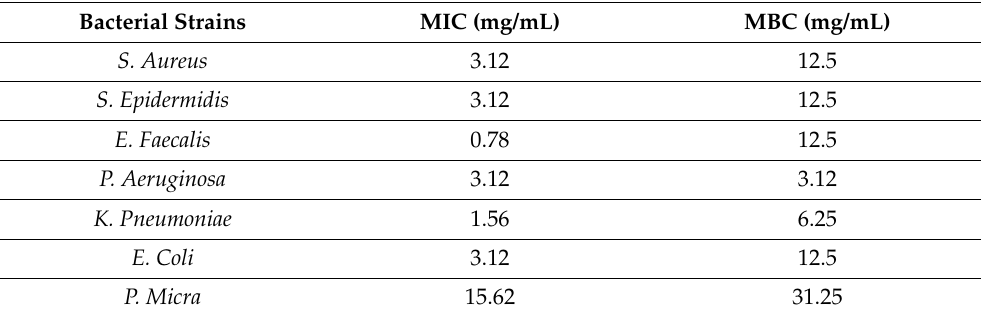
Table 2. Minimum inhibitory concentrations (MIC) and Minimum bactericidal concentrations (MBC) of C-CaOH 2 NPs against bacterial strains.